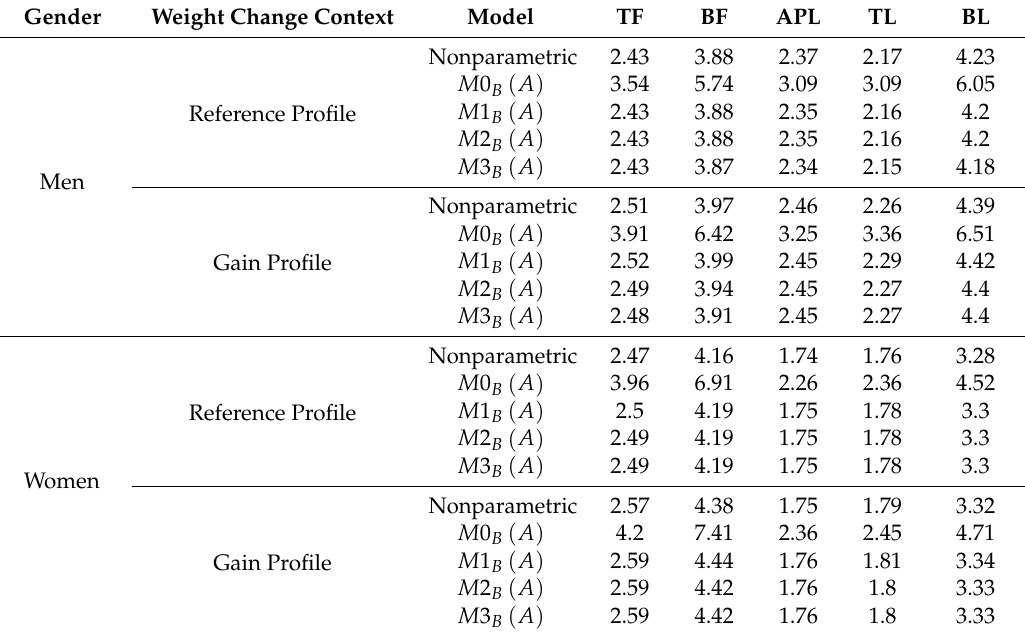
Table 6. For effect of BMI, standard error of the estimate (kg) of different models in European-American men and women. In columns, the five segmental body compositions, in rows, the different models for two weight trend